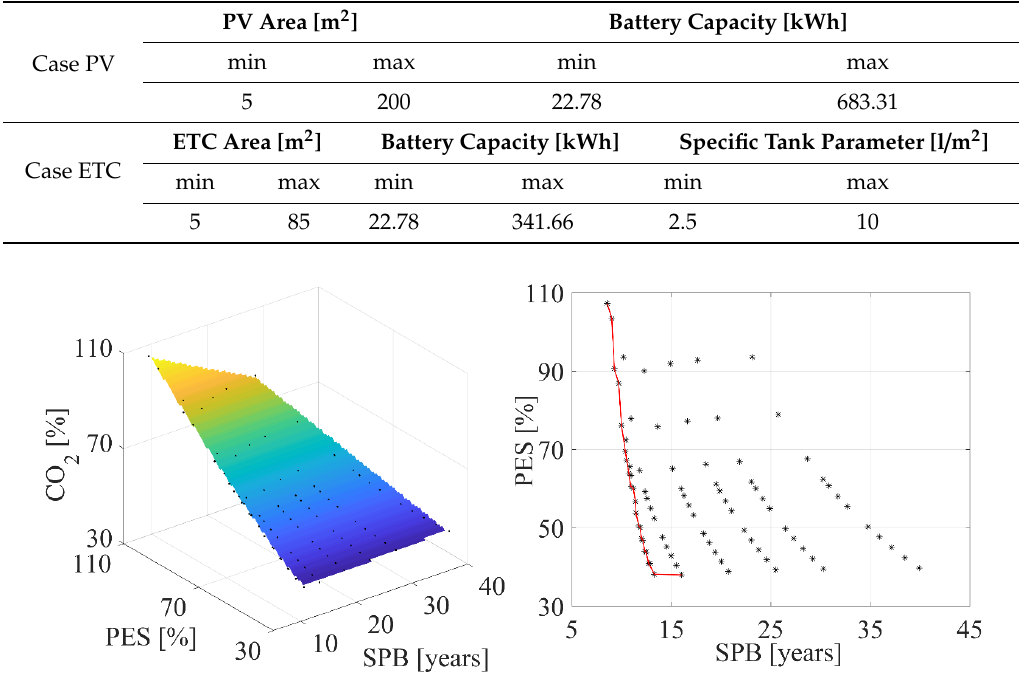
Figure 15. 2D Pareto frontier ( left ) and Optimal configuration research for Case PV ( right ).